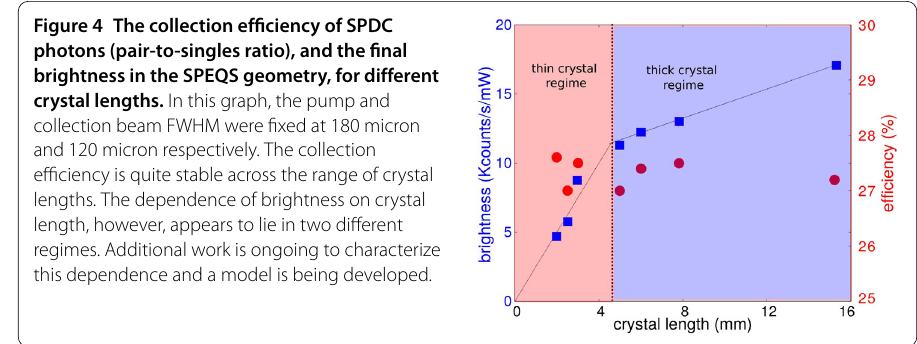
Figure 4 The collection efficiency of SPDC photons (pair-to-singles ratio), and the final brightness in the SPEQS geometry, for different crystal lengths. In this graph, the pump and collection beam FWHM were fixed at 180 micron and 120 micron respectively. The collection efficiency is quite stable across the range of crystal lengths. The dependence of brightness on crystal length, however, appears to lie in two different regimes. Additional work is ongoing to characterize this dependence and a model is being